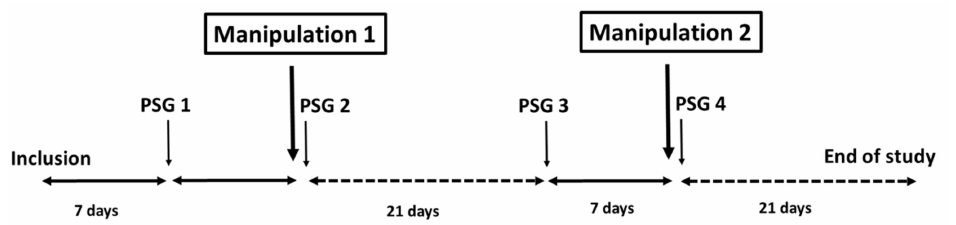
Figure 1. Study plan for OSAS patients. PSG: polysomnography.